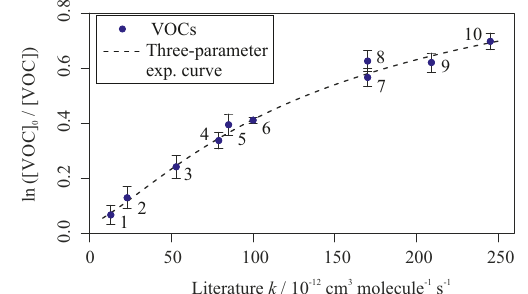
Figure 3. Relative rate plot for Mixture 1 (OH reactivity is 240s − 1 ) at 295K. Compounds with a known rate coefficient are plotted us- ing literature values. Error bars on the y axis, equal to 1 standard error, are calculated by combining the standard error in peak areas for six lamp-off samples and six lamp-on samples. Error bars on the x axis are typically large (approximately ± 20–30%) and ac- count for deviations from the line. A weighted (to the uncertainty in the y values) linear fit was used to generate the slope with a value of OH exp = 1.1 ( ± 0.07) × 10 9 moleculescm − 3 s and R 2 of 0.96. Identities of VOCs: 1, o -xylene; 2, m -xylene; 3, α -pinene; 4, β -pinene; 5, 3-carene; 6, isoprene; 7, limonene; 8, γ -terpinene; 9, myrcene; 10, β -ocimene.